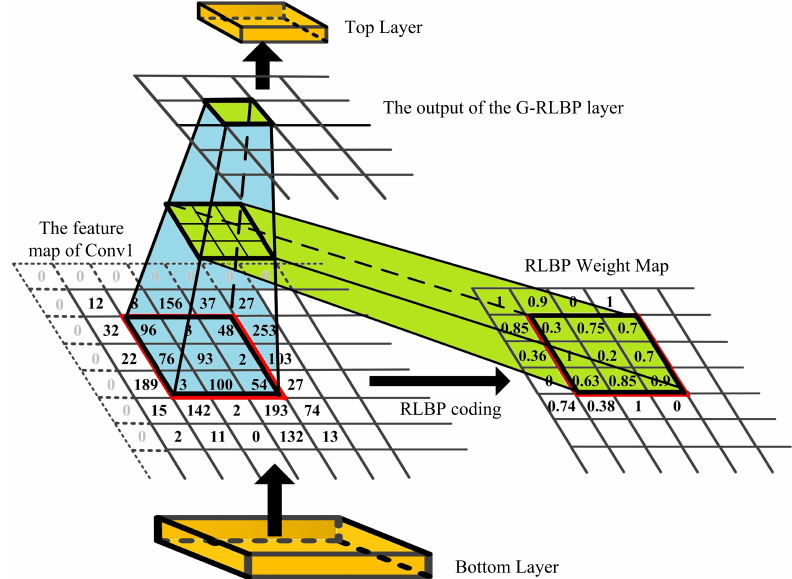
Figure 8. The visualization of the G-RLBP pooling process in the designed